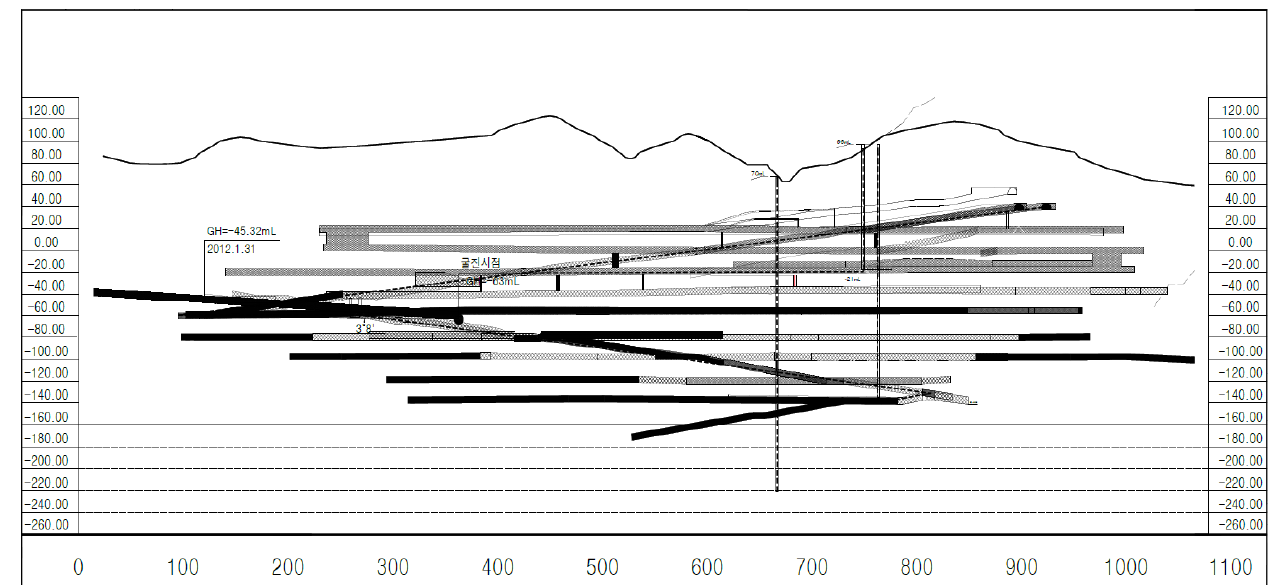
Figure 5. Developed longitudinal section of Gun-dong mine along the north-south direction showing various mine excavation levels as of 2018. Black and grey pattern used are to create perspective showing lateral and vertical distribution of various mine levels.